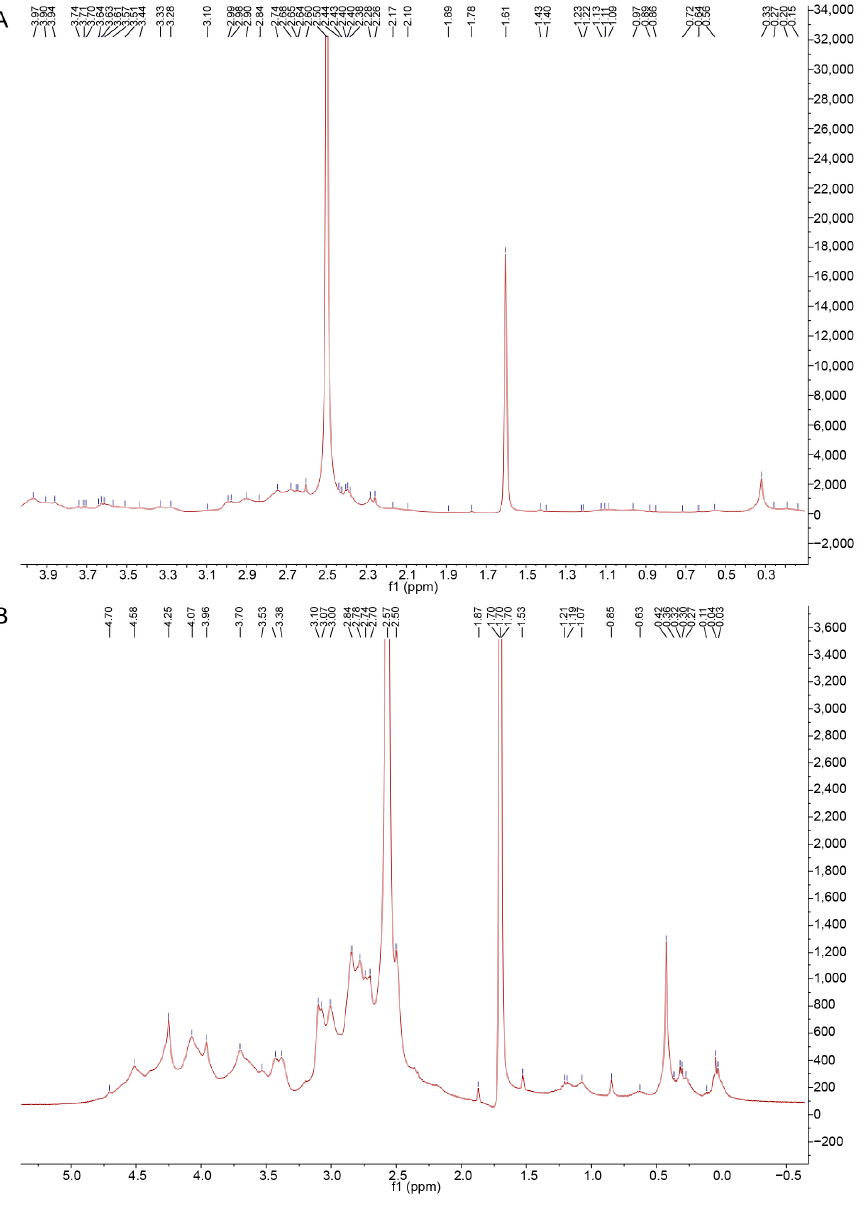
Figure 5. 1 H ‐ NMR spectra of CTLP ‐ 1 ( A ) and CTLP ‐ 2 ( B ). Figure 5. 1 H-NMR spectra of CTLP-1 ( A ) and CTLP-2 ( B ). For the mixture of CTLP-1 and CTLP-2 with Congo red, the wavelength of max- For the mixture of CTLP ‐ 1 and CTLP ‐ 2 with Congo red, the wavelength of maximum imum absorption continuously decreased with the increase in sodium hydroxide con- absorption continuously decreased with the increase in sodium hydroxide concentration, centration, due to the safflower polysaccharides reacting with Congo red to form new due to the safflower polysaccharides reacting with Congo red to form new complexes complexes [19,28]. As the NaOH concentration increased, the maximum absorption [19,28]. As the NaOH concentration increased, the maximum absorption wavelength of